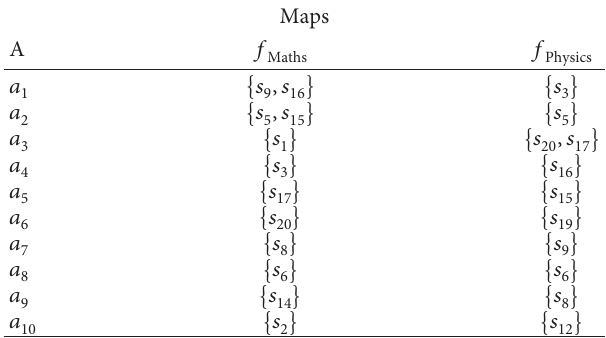
Table 2: Maps of subjects. Table 3: Students’